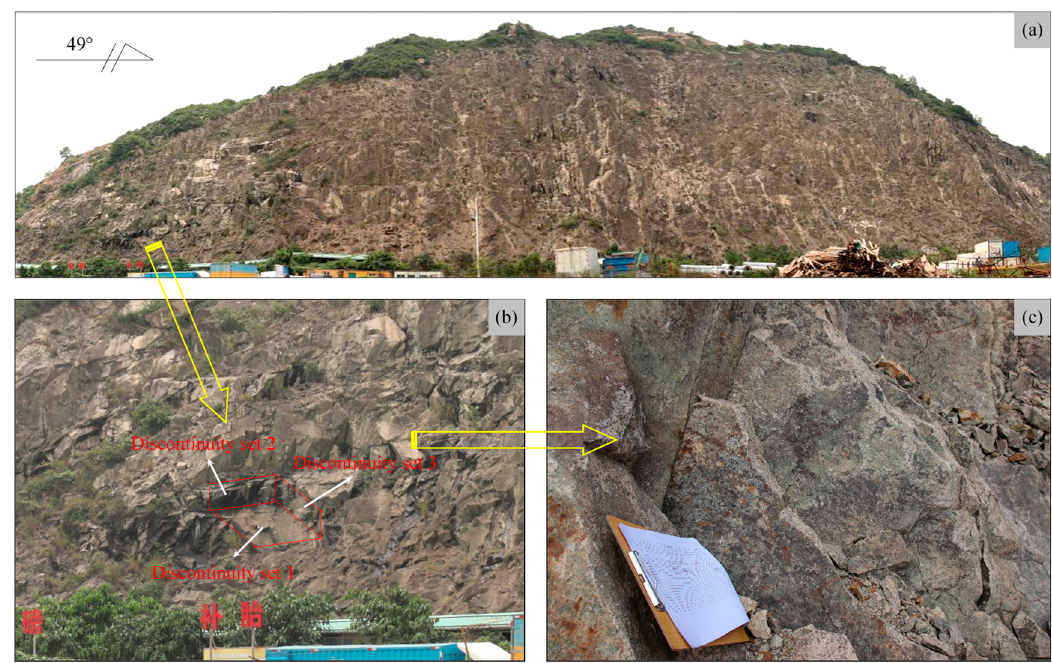
Figure 3. Fractures and dangerous rock bodies developed on the slope surface; ( a ) Overall shape of slope; ( b ) Fracture development; ( c ) Dangerous block.